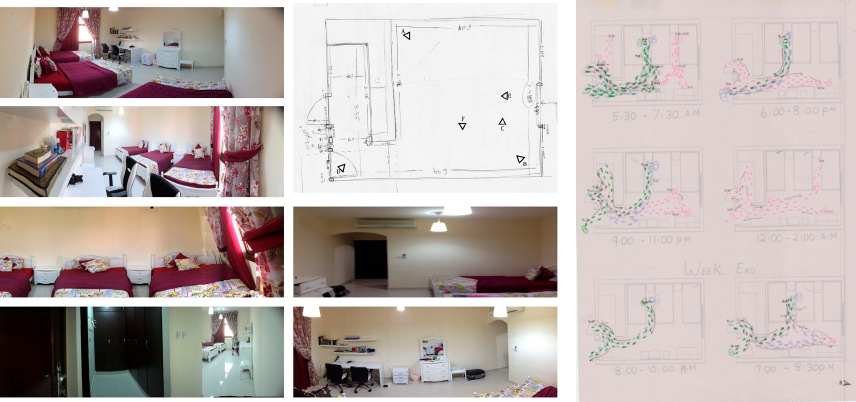
Figure 1. Communication of the bedroom space, and movement ‐ time analysis.